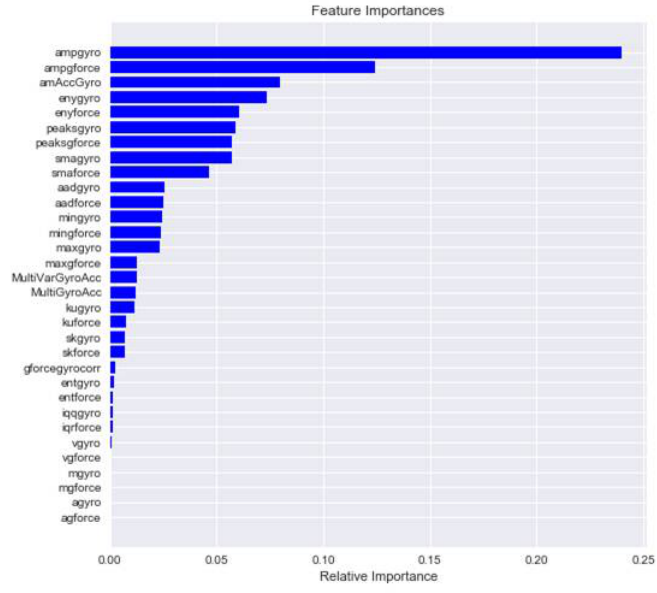
Figure 4. Feature